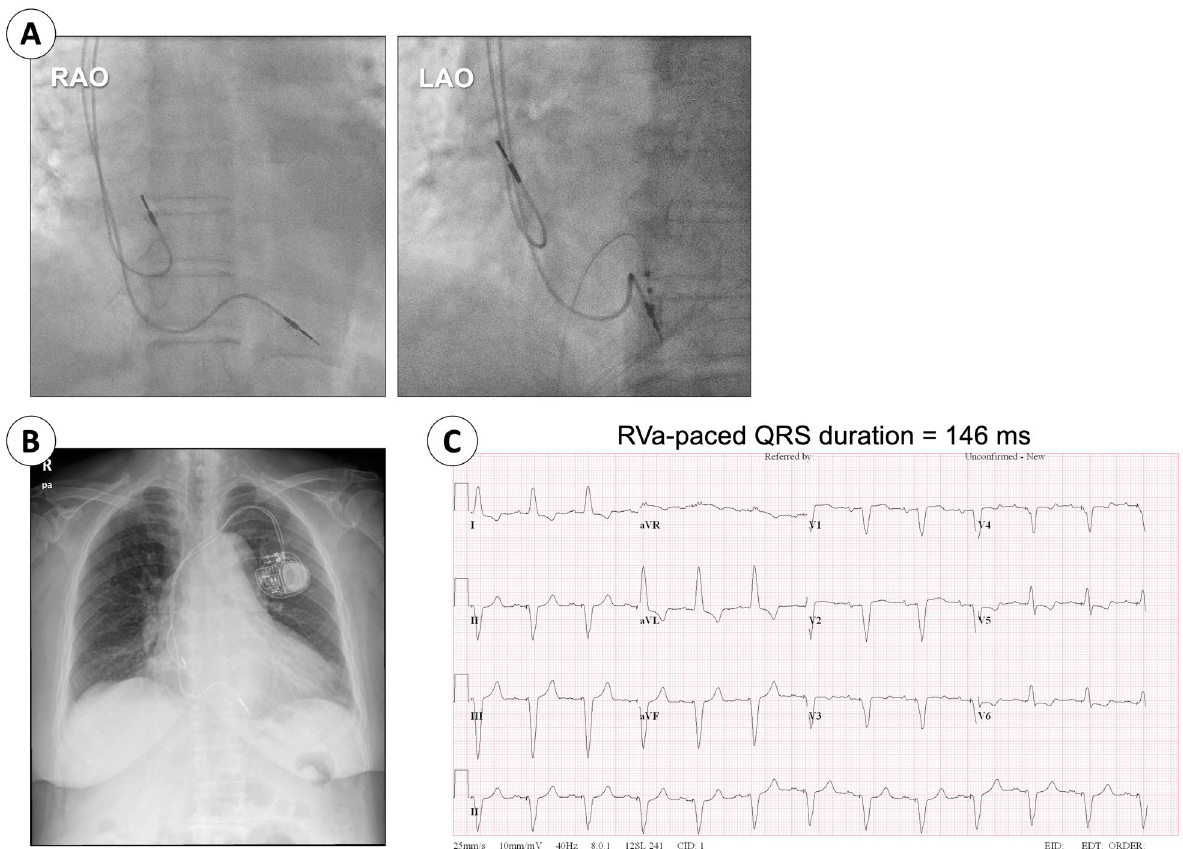
Fig. 2 Results of permanent pacemaker implantation with dual pacing. A The ventricular lead was placed at the RVa. B After pacemaker implantation and heart failure management, pulmonary edema was resolved. C An electrocardiogram during RVa pacing showed paced QRS duration of 146 ms. LAO left anterior oblique view, RAO right anterior oblique view, RVa right ventricular